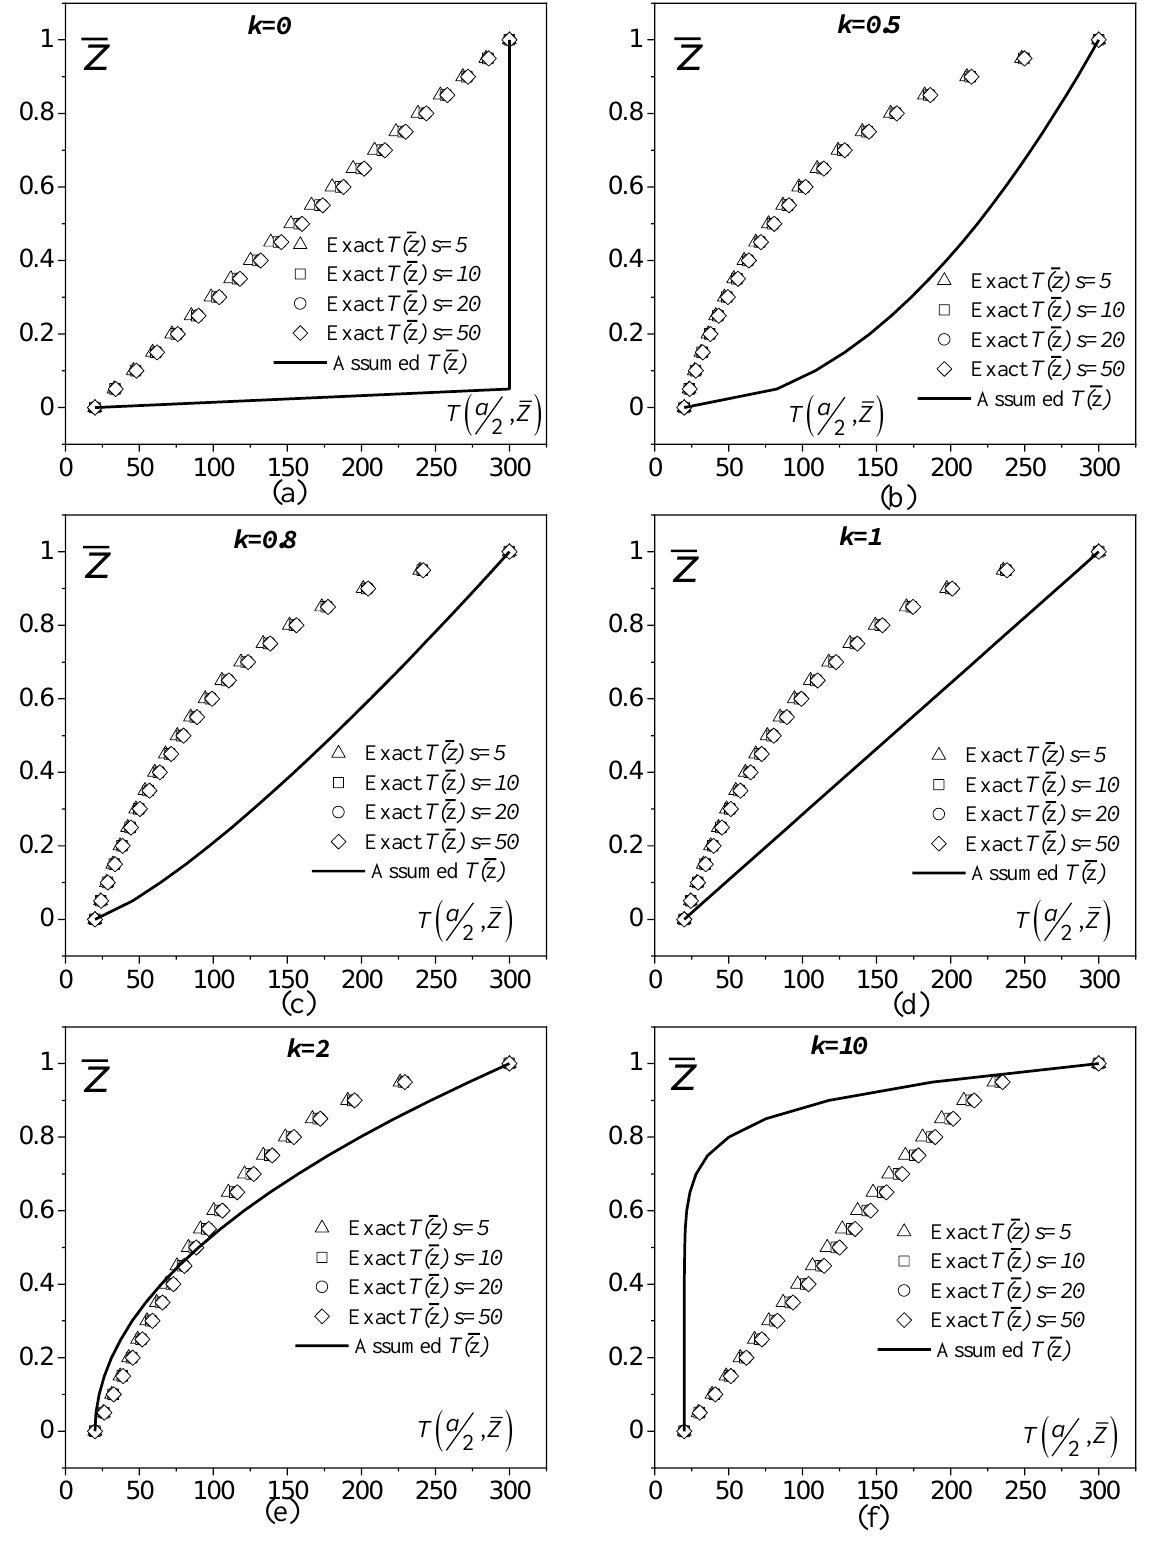
Fig. 2. Comparison between through thickness exact temperature variation and power law variation for various power index ( k) of FG laminate Material set